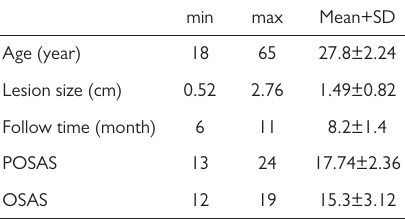
Table 3. Mean values of patient datas